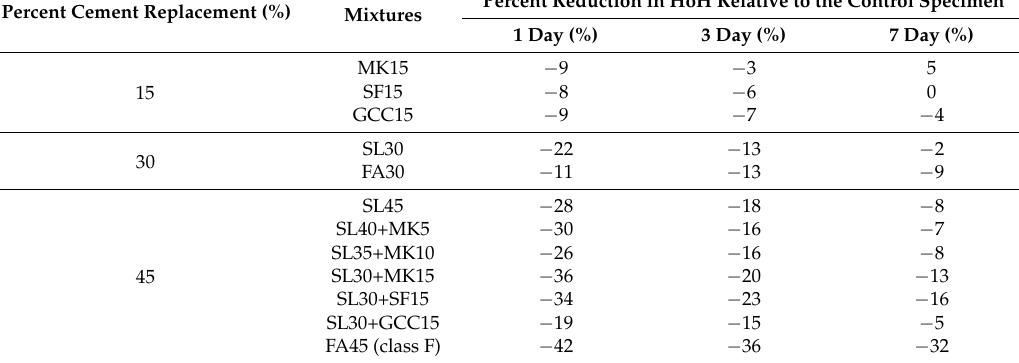
Table 3. Percent reduction in heat of hydration in binary and ternary mixtures relative to the 422 control